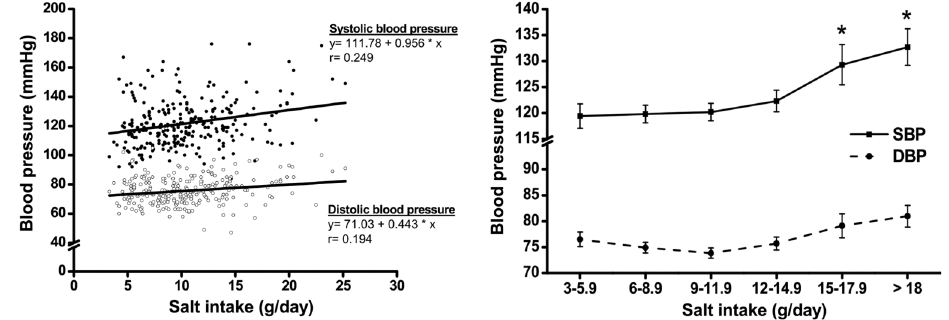
Figure 2. Association of salt intake with blood pressure. The left panel shows linear regression analysis between an increase in systolic and diastolic blood pressure as a function of salt intake. The right panel shows blood pressure adjusted for age and body mass index as a function of salt intake. Adjusted systolic and diastolic blood pressures were more sensitive to salt intake over 9 g/d. Data are reported as means ± SE. *P o 0.01 vs o 9 g/d of salt consumption (two-way ANOVA and post hoc Bonferroni test).